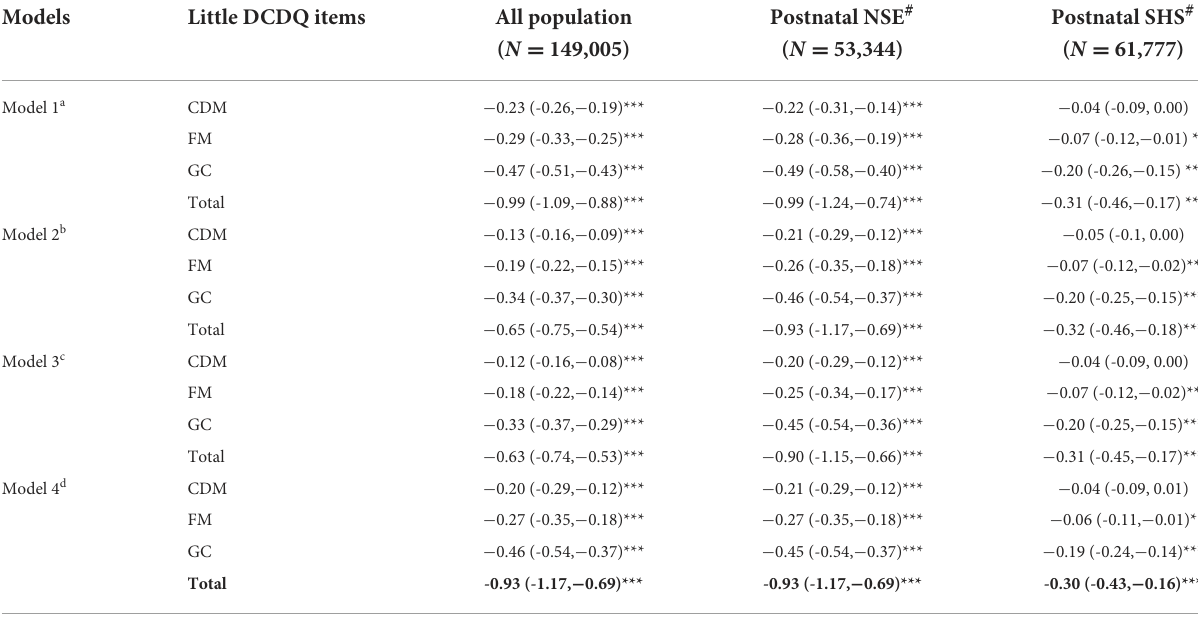
TABLE 3 Association of prenatal SHS exposure with sub and total scores of the LDCDQ, postnatal SHS-exposed stratification analysis ( N = 149,005, β , 95% CI). Models Little DCDQ items All